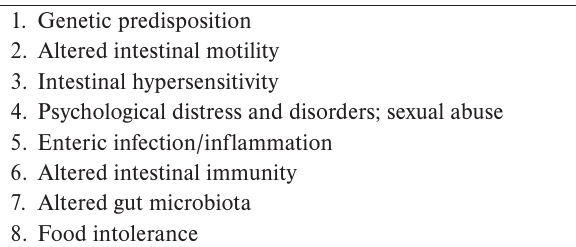
Table 1. Factors potentially involved in the pathogenesis of irritable bowel syndrome 15